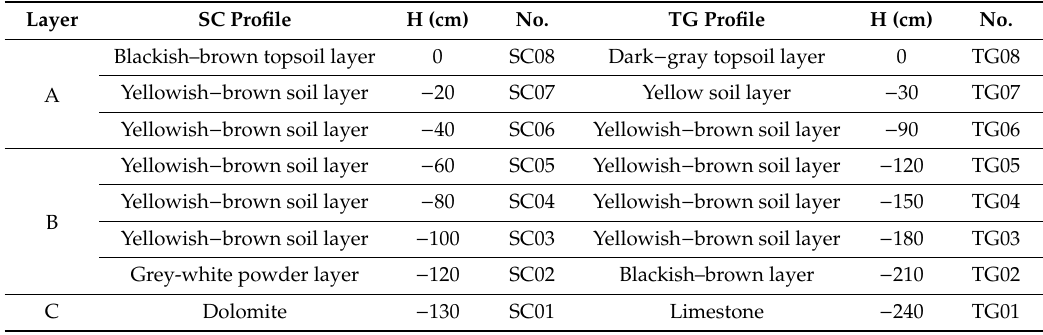
Figure 1. The simplified stratigraphic sketch of the SC dolomite and TG limestone (located at Sang Cai, Hoa Binh province and located at Tong Gia, Lao Cai province, respectively, showing the location of the numbered sampling points. 1, plow layer; 2, terra rossa; 3, rock − soil interface (RSI) of dolomite rock (blackish-brown chocolate layer); 4, RSI of limestone (grey-white powder layer); 5, dolomite; 6, limestone; 7, sampling point. Table 1. Detailed information and sampling sites of the two typical laterite